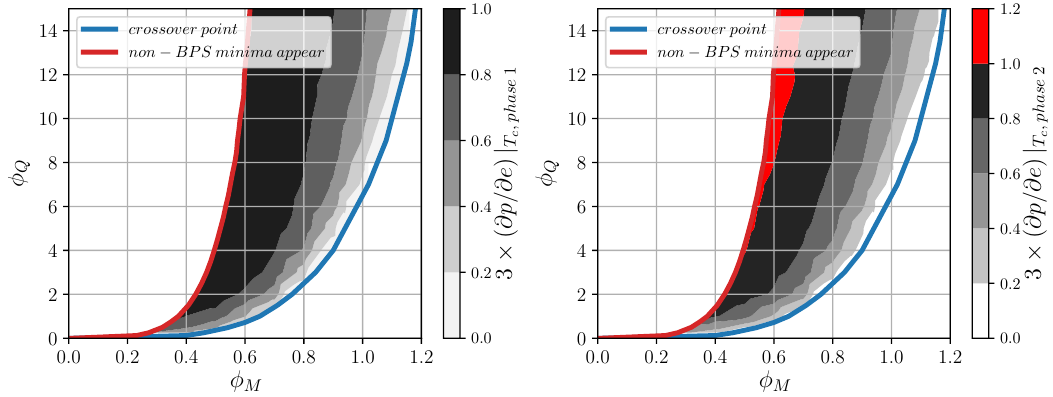
Figure 9 . Scan of 3 × ∂p/∂e at the critical temperature in both phases, with phase one (the symmetric phase) on the left and phase two (the broken phase) on the right. Values that fall above the conformal stiffness value ∂p/∂e = 1 / 3 are shown as a red filled contour. towards a crossover transition. The effect this could have on the signal is has been recently discussed in [55, 88] and is described in appendix